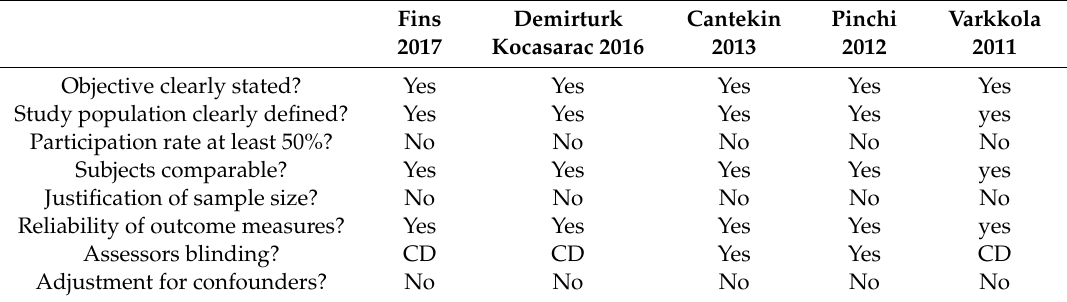
Table 8. Methodological quality appraisal of studies regarding the accuracy of dental methods for age estimation.